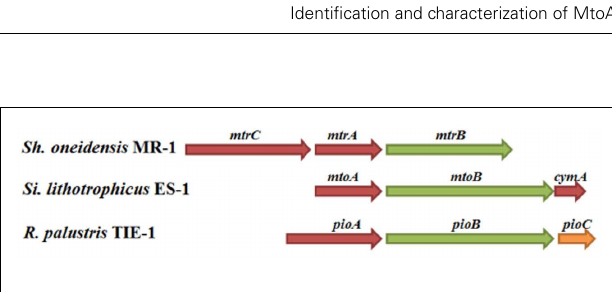
FIGURE 1 | Genetic organization of mtoA , mtoB , and cymA of Sideroxydans lithotrophicus ES-1. Shown are the relative positions of mtoA , mtoB , and cymA within the complete nucleotide sequence of S. lithotrophicus ES-1.The genes are labeled by arrows whose sizes and orientations indicate their relative lengths and directions in which they are presumed to be transcribed. For comparison, mtrCAB of Shewanella oneidensis MR-1 and pioABC of Rhodopseudomonas palustris TIE-1 are included.The genes encoding c -type cytochromes are labeled in red, while those encoding the β -barrel outer membrane proteins are labeled in